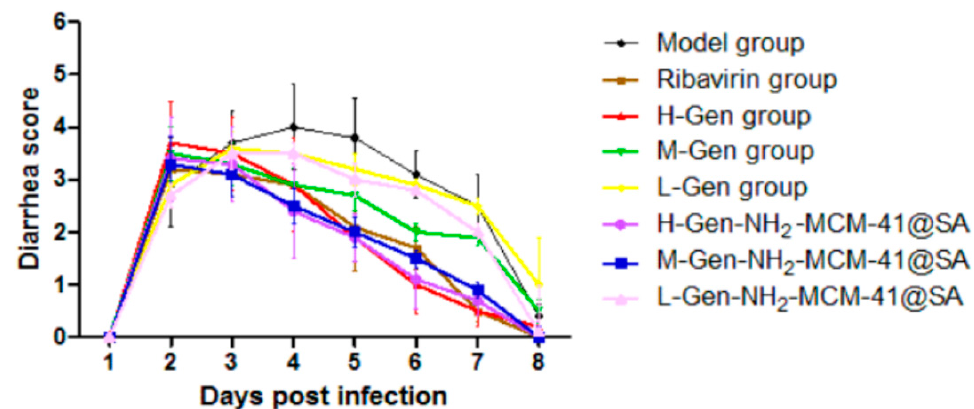
Figure 19. Diarrhea score of suckling mice in different groups.